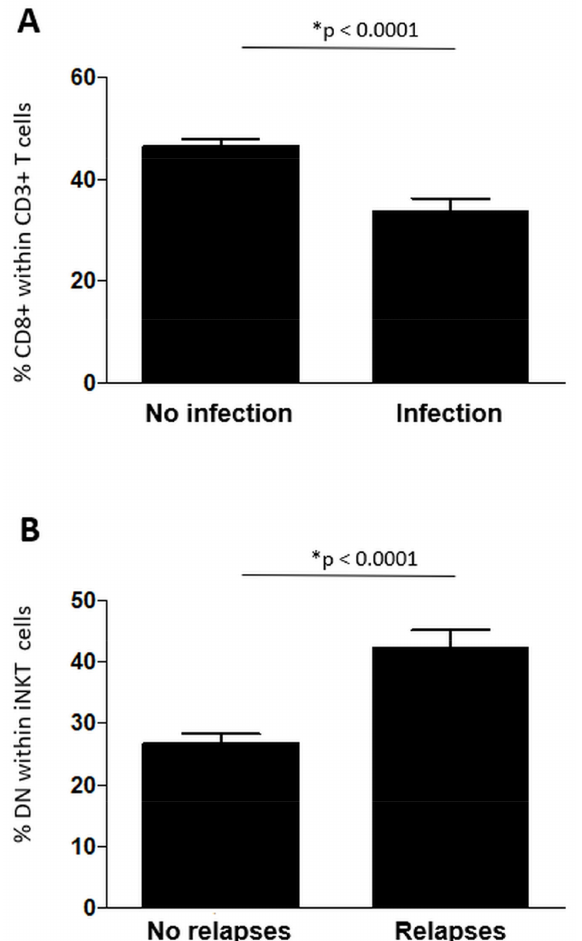
Figure 4. Mean percentage of CD8+ T cells in patients with ( N = 7) and without ( N = 29) clinically significant infections during the treatment period (panel A ). Mean percentage of DN iNKT cells in patients with ( N = 10) and without ( N = 29) a clinical relapse during the treatment period (panel B ). Data are represented as plus or minus standard error of the